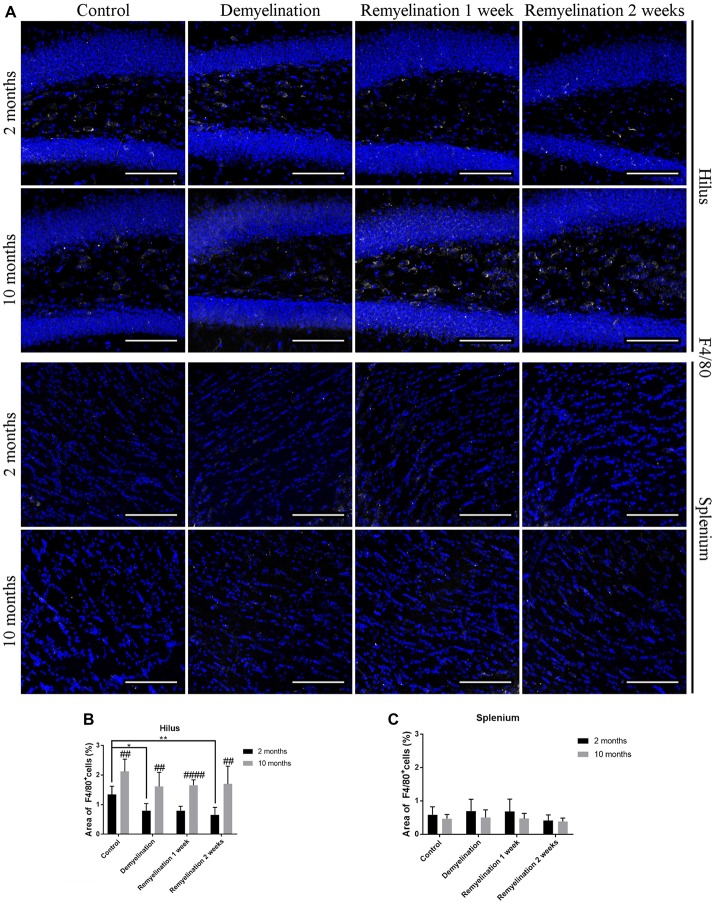
F4/80 levels are affected by age and cuprizone treatment in the hilus of the DG, but not in the splenium of the CC. (A) F4/80 (white) staining in the hilus of the DG (two upper rows) and the splenium of the CC (two lower rows). Cell nuclei are stained with DAPI (blue). F4/80 is relatively low in all groups. (B) In the hilus of the hippocampal DG, F4/80 levels were higher in middle-aged groups compared to young ones. In young mice, F4/80 was significantly reduced after demyelination and 2 weeks of remyelination. (C) In contrast, in the splenium of the CC no significant changes in F4/80 expression were found. Values are shown as means + SD (n = 6 per group). Statistical significance was evaluated using a two-way ANOVA followed by a Tukey’s post hoc test. The p-values are indicated in the graphs: treatment effects within the same age group: *p < 0.05 and **p < 0.01, age-related differences: ##p < 0.01 and ####p < 0.0001. Bars: (A) 100 μm.